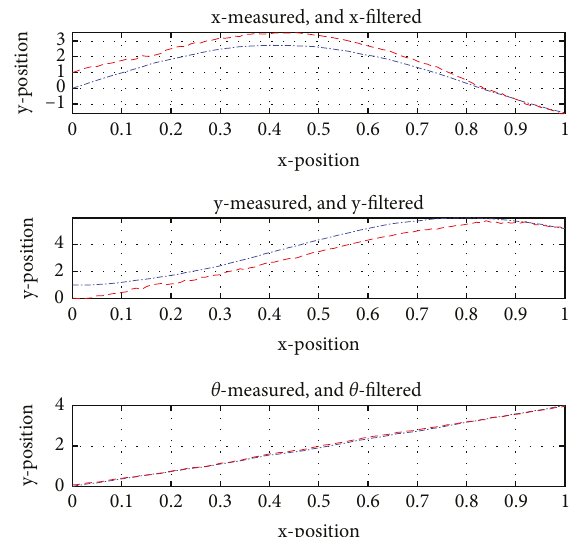
Figure 2: EKF performance with one landmark and Gaussian noise.